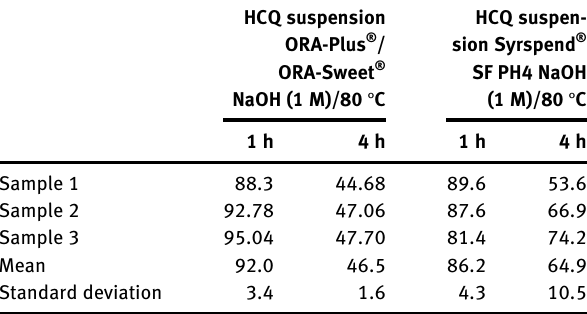
Table  : Relative concentrations of HCQ (%) in each oral vehicle suspension after NaOH (  M) and Heat (  ° C) stress condition during  or  h(%).